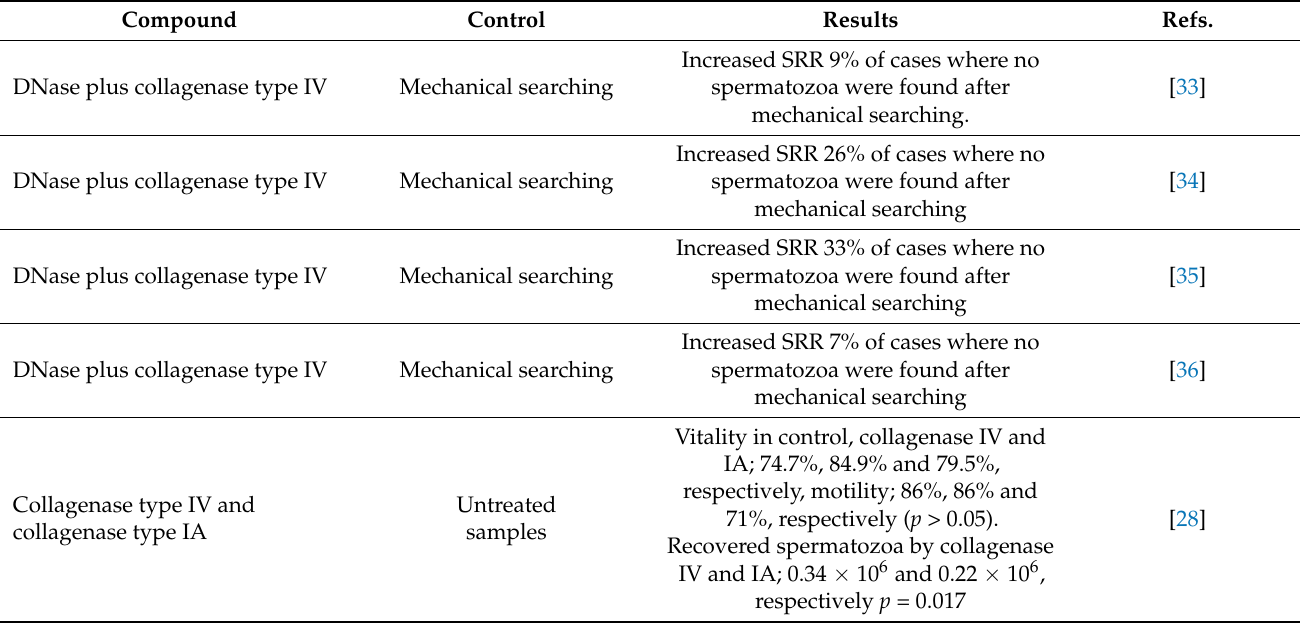
Table 1. Clinical results of enzymatically tissue processing methods for sperm recovery by TESE. Compound DNase plus collagenase type